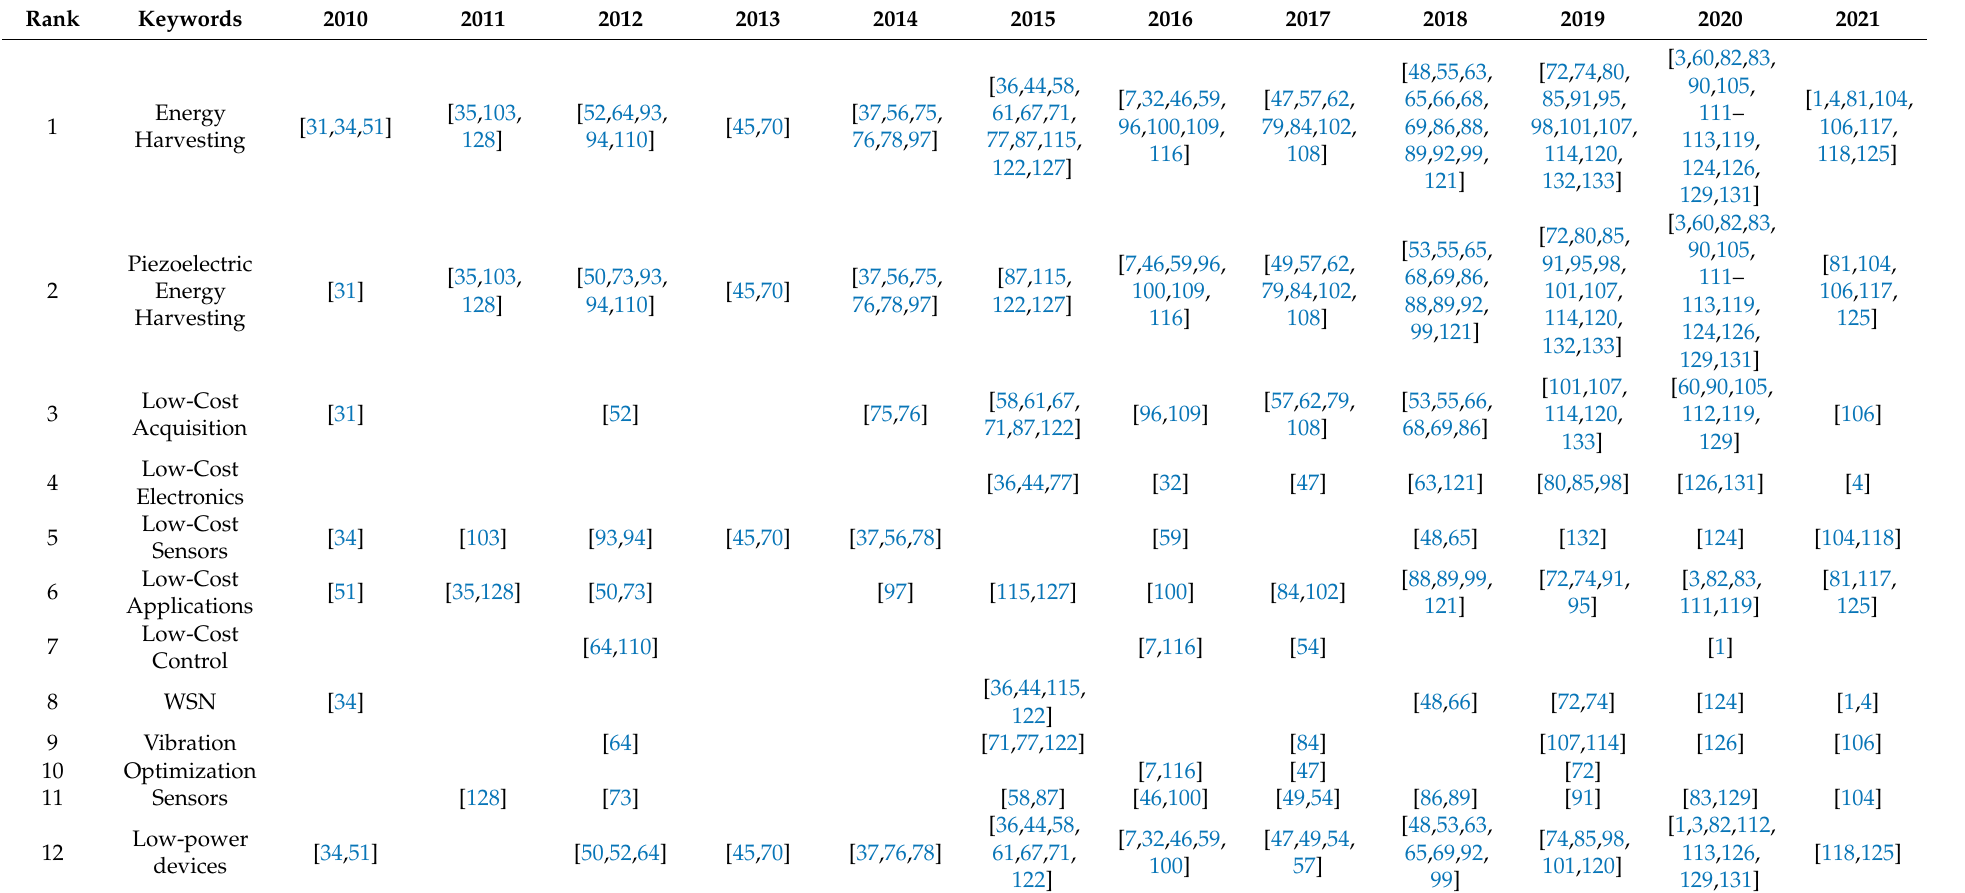
Table 9. Relevant 13 most common keywords used in different articles from the year 2010 to